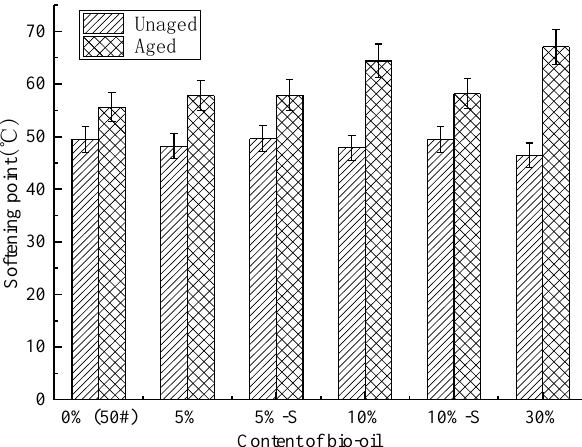
Figure 4. Softening point of unaged and RTFO aged bio-asphalt.